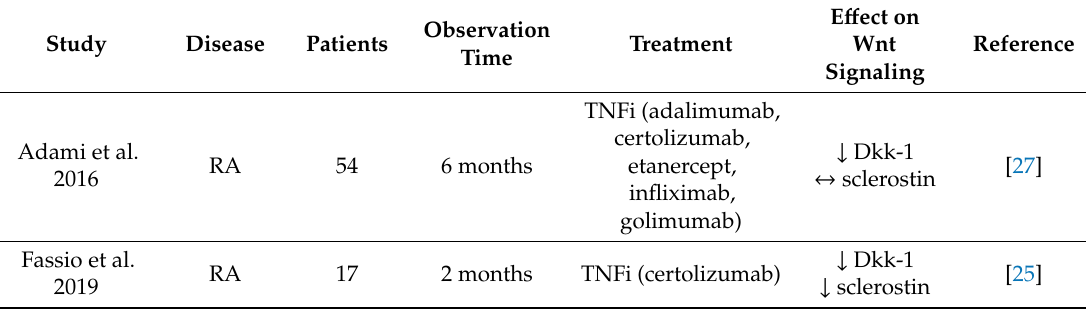
Table 1. Wnt signaling and biological therapy in